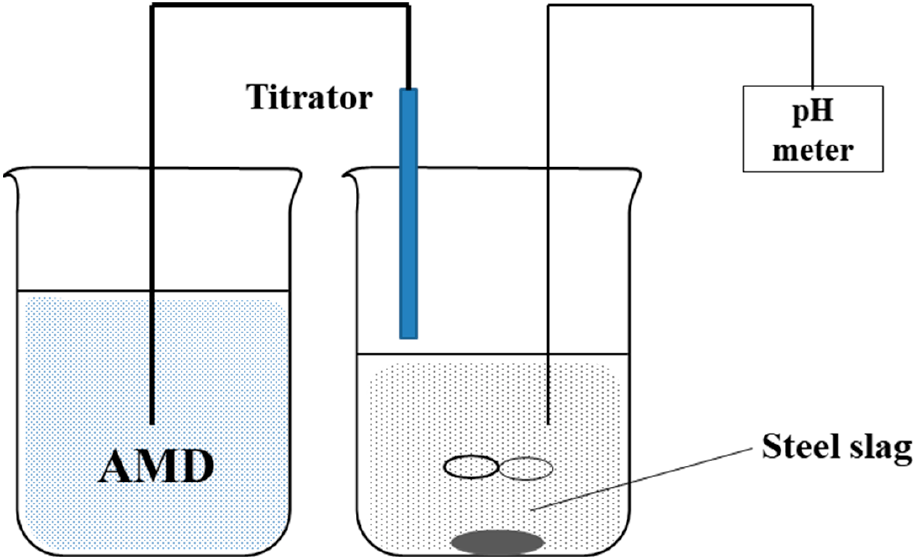
Figure 1. Setup of ANC determination experiment.